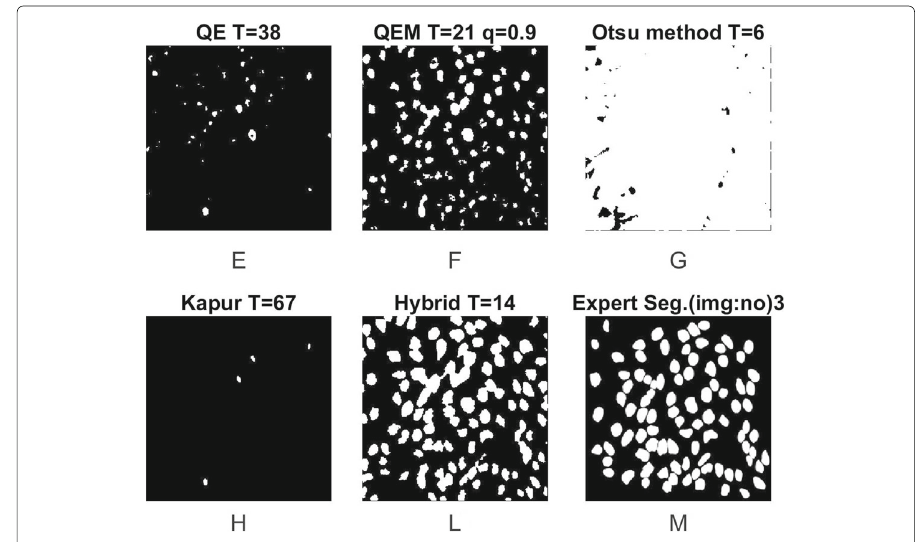
Fig. 2 F-measure [0.0865 0.5371 0.4275 0.0160 0.7707] for quantum entropy, modified quantum entropy (proposed), Otsu, Kapur, and hybrid of the proposed with Otsu methods, respectively